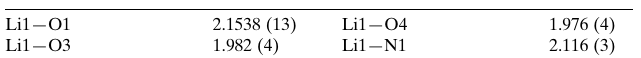
Selected bond lengths (A˚ ).